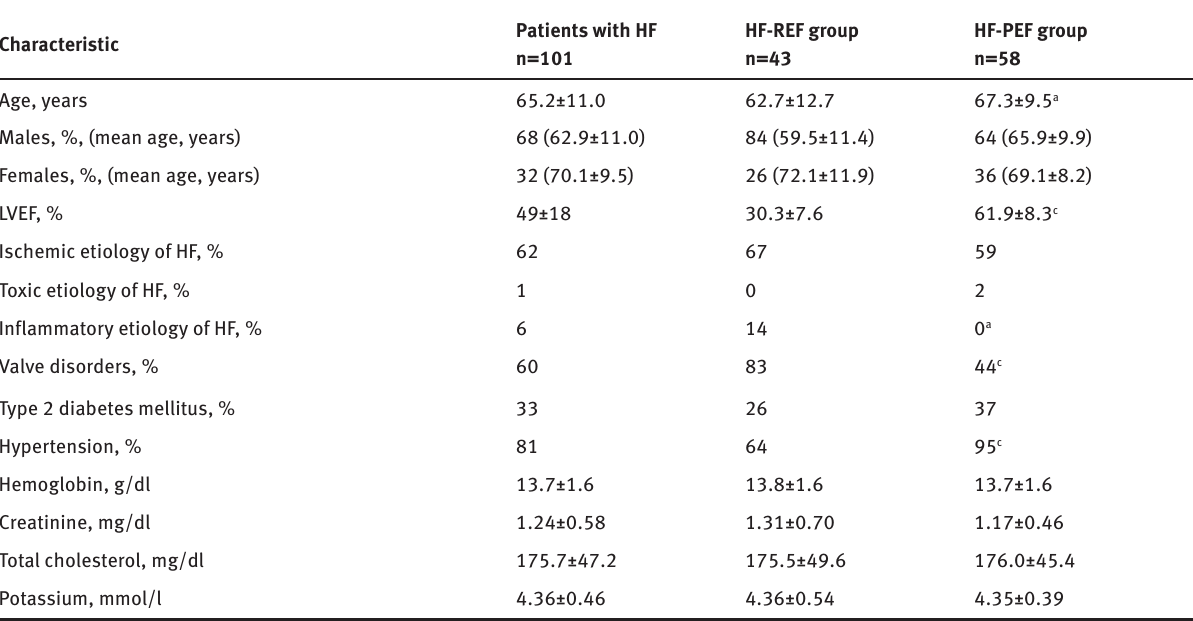
Table 1: Patient characteristics (classification according to the level of ejection fraction).